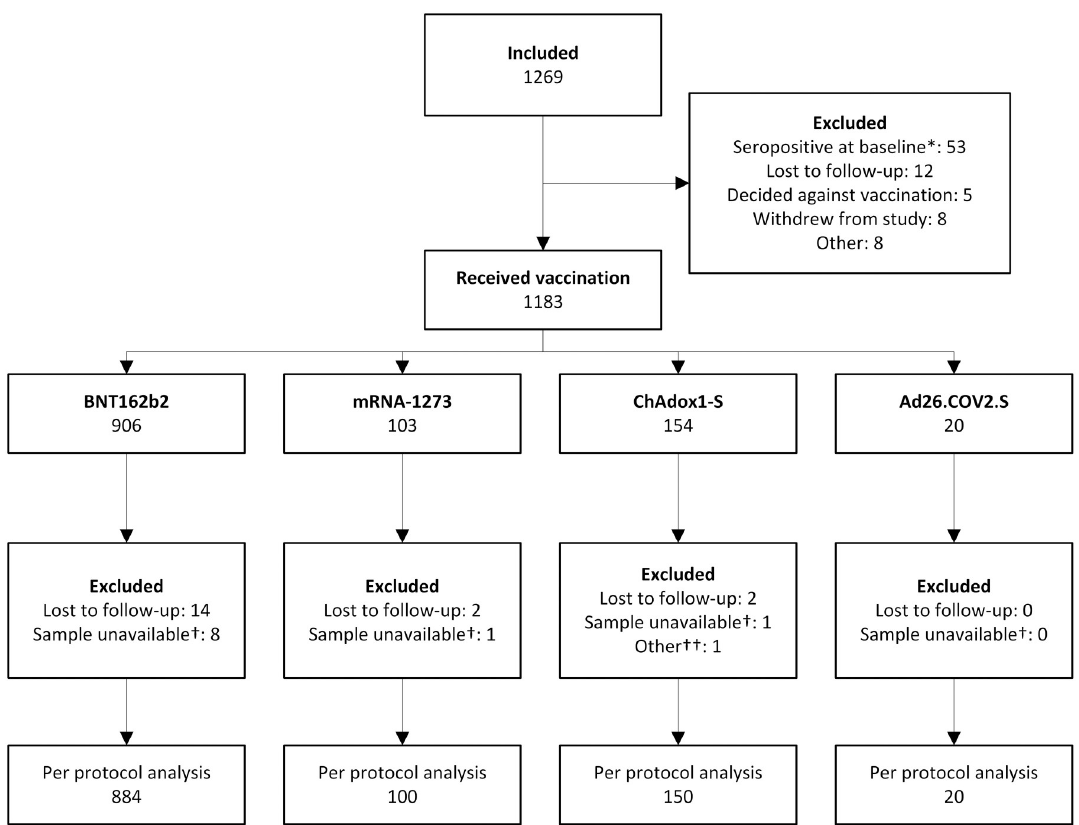
Fig 1. Flow chart of included PLWH. � Participants who tested positive for SARS-CoV-2 antibodies in serum at baseline measurement were excluded from further articipation † Samples were not stored adequately or were not sent to be analysed in the central laboratory